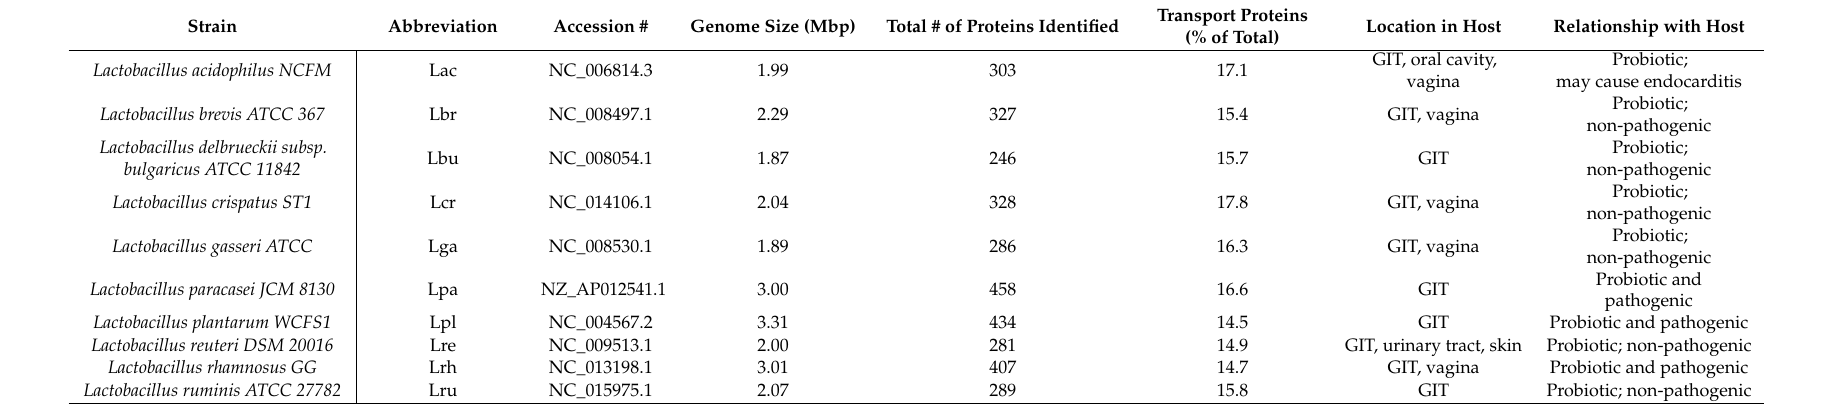
Table 1. Overview of the ten Lactobacillus species included in this